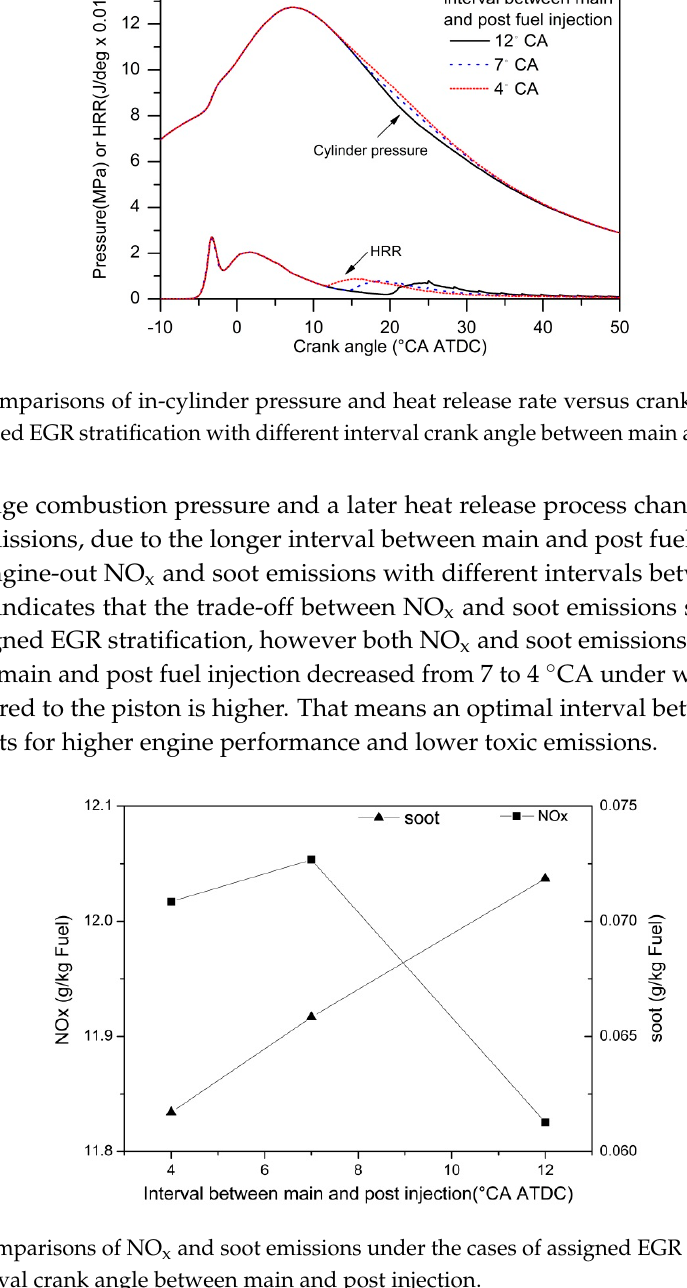
Figure 12. Comparisons of NO x and soot emissions under the cases of assigned EGR stratification with different interval crank angle between main and post injection.